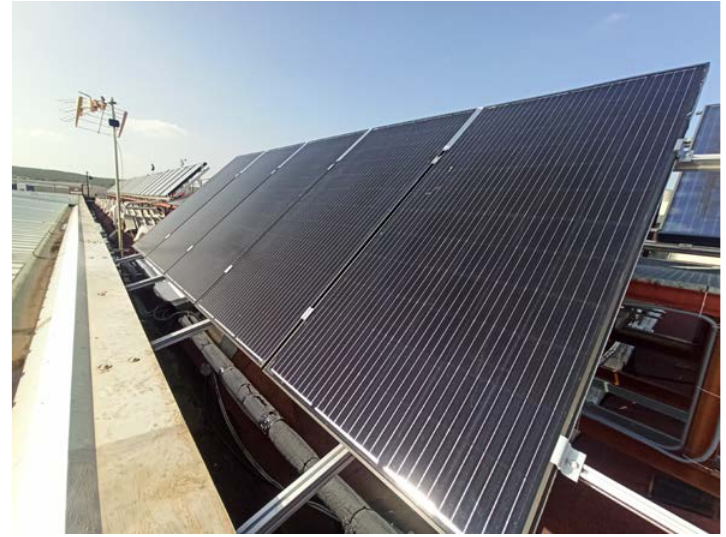
Figure 3. 5-panel PVT pilot plant on industrial facility.